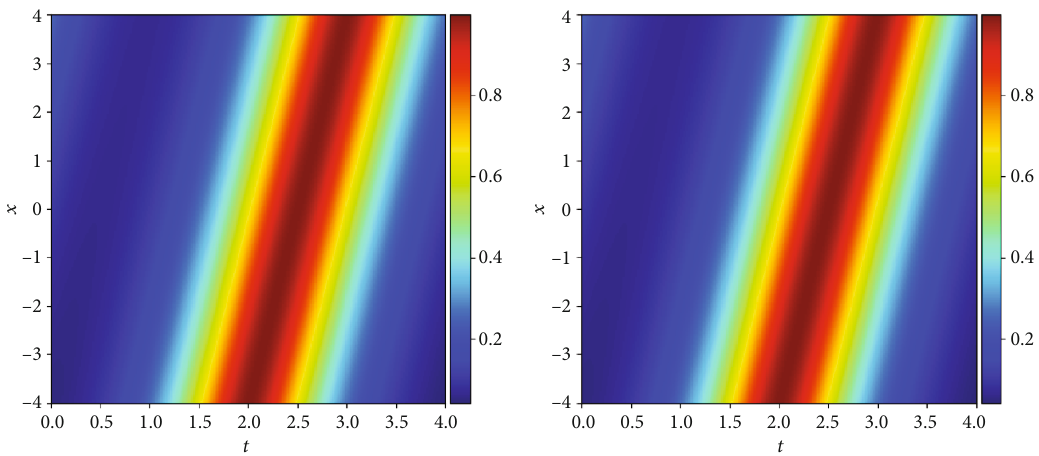
Figure 10: Exact dynamics and learned dynamics of u ð x , t Þ Table 3: mkdv equation: L 2 -norm error between the predicted and exact solutions of u ð t , x Þ for di ff erent numbers of hidden layers and di ff erent numbers of neurons per layer. The number of training points is N u = 100 and collocation points is N f = 10000 .